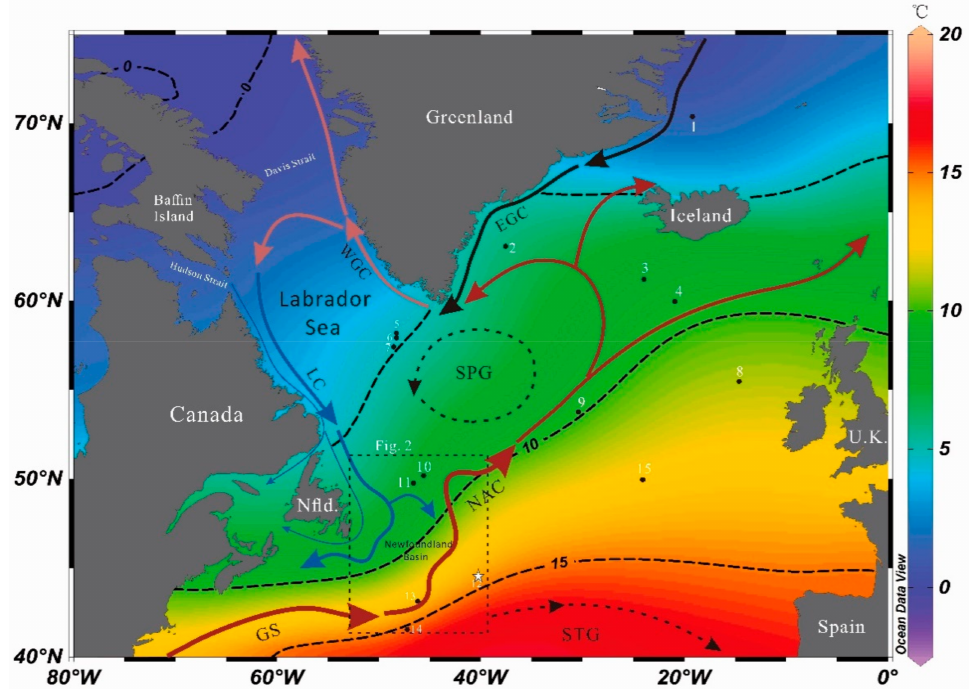
Figure 1. General oceanographic features of the modern northwest Atlantic Ocean. The mean annual sea-surface temperature with 5 ◦ C contour demarcates between the subpolar and subtropical gyres. The location of the cores used in this study is listed in Table 1. Note that “white star” denotes the location of core Hu90-08 (this study). The tabular box with the discontinuous line shows the location of Figure 2. GS = Gulf Stream; NAC = North Atlantic Current; EGC = East Greenland Current; WGC = West Greenland Current; LC = Labrador Current; SPG = Subpolar gyre; and STG = Subtropical